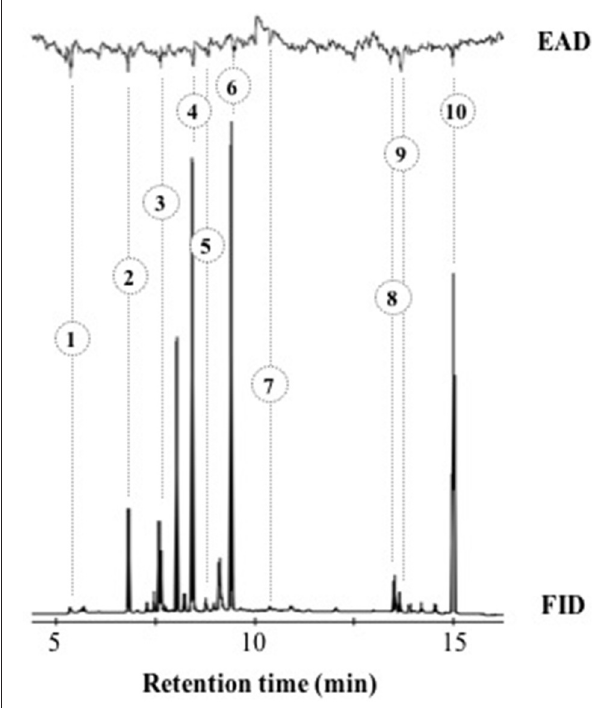
FIGURE 2 | Representative GC-EAD recording of Anthonomus grandis responses to reproductive boll weevil-damaged cotton volatiles. As male and female responses were not different, only one trace is shown. The FID peaks marked are those which elicited responses in two or more runs: 1 = ( E )-2-methylbutanal oxime, 2 = α -pinene, 3 = ( Z )-3-hexenyl acetate, 4 = ( E )-ocimene, 5 = ( R )-linalool, 6 = ( E )-4,8-dimethyl-1,3,7-nonatriene (DMNT), 7 = methyl salicylate, 8 = ( E )-(1 R ,9 S )-caryophyllene, 9 = geranylacetone, and 10 = ( E,E )-4,8,12-trimethyl-1,3,7,11-tridecatetraene (TMTT). The stereochemistry of linalool was inferred from a separate analysis on a chiral column.